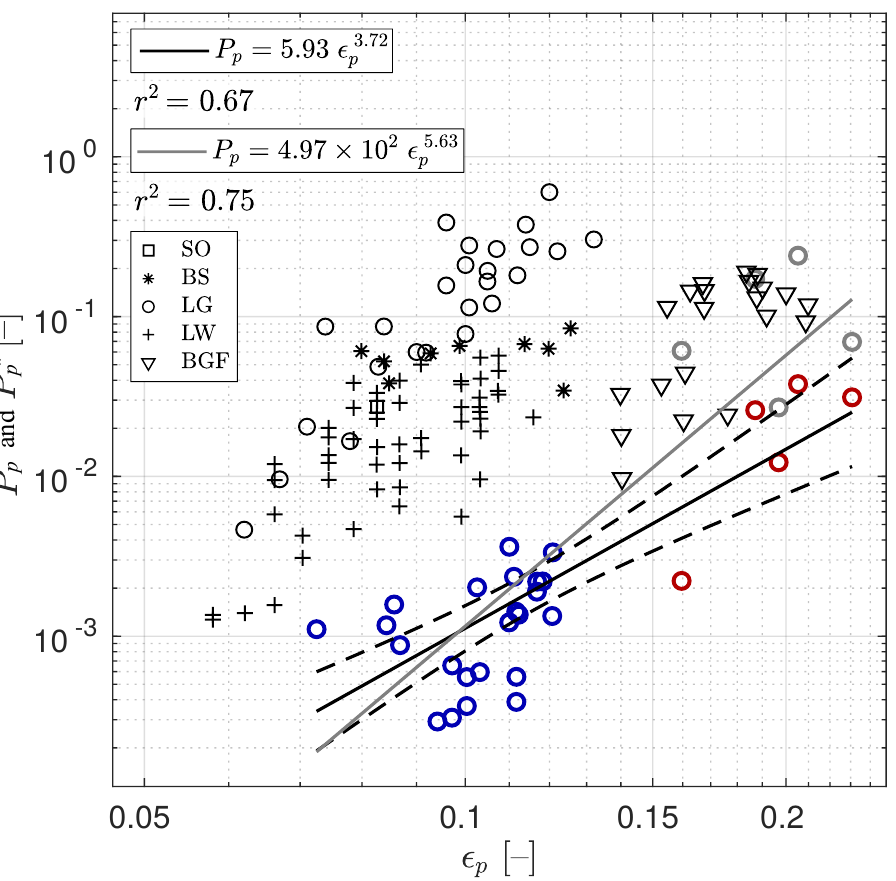
Figure 10. Estimated probability of dominant wave breaking, P p , as a function of the dominant wave steepness, (cid:101) p , together with previously reported field data, shown as black markers. In the legend: SO—Southern Ocean, BS—Black Sea, LG—Lake George, LW—Lake Washington data described in [30,31], and BGF—data points of [32]. Notation and colour-coding are the same as in Figures 8 and 9. Gray markers are for the P ∗ p at the offshore winds. The gray line corresponds to the power fit to the total cloud of points when red markers are replaced with gray